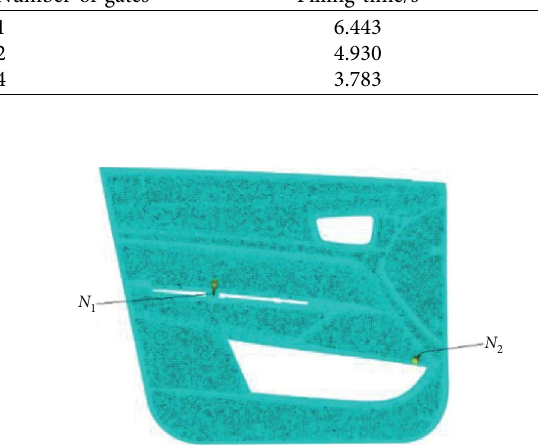
Figure 10: Initial gate location diagram of two gate schemes.